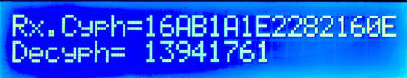
16 of 20 Figure 13. Initial states displayed after reset or power-on: ( a ) master node, ( b ) normal slave node. When the first header is published, the slave node first checks the PID, which must match its own. In such case, the encrypted data are calculated and sent as a standard LIN response. After reception, the master publishes an identical header, and the slave node calculates the HMAC and sends it to the master, again as a standard LIN response. Then, on the screen, the slave shows the execution times ( 𝜇𝑠) for both the encryption (“Cy- phT=”) and HMAC (“HMACT=”) calculations on each of the two passes (Figure 14). These times are obtained using an internal hardware counter. If the PID does not match, no re- sponse is sent by the slave node. Figure 14. Normal slave node’s screen status after sending the two interleaved LIN responses. On the master ’ s side, two internal RAM buffers are used to separately receive the